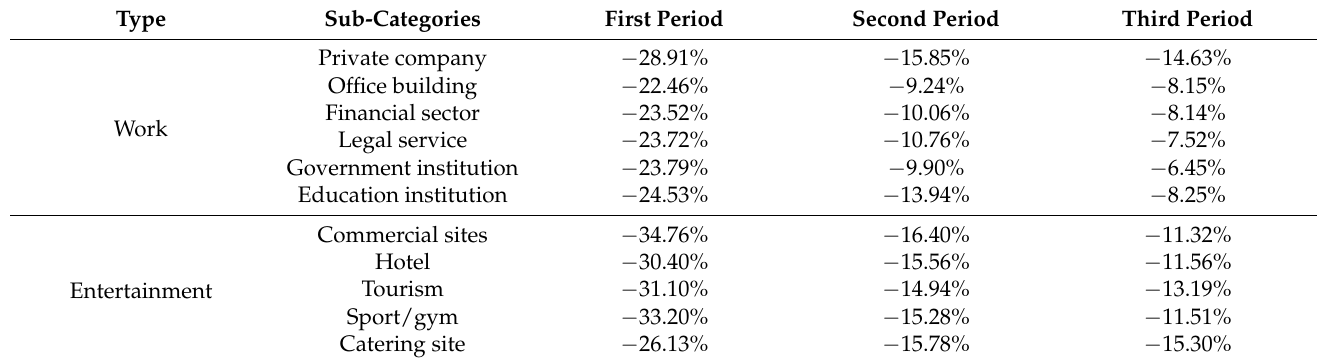
Table 4. Change in the human activity intensity in the three periods for the entertainment and work